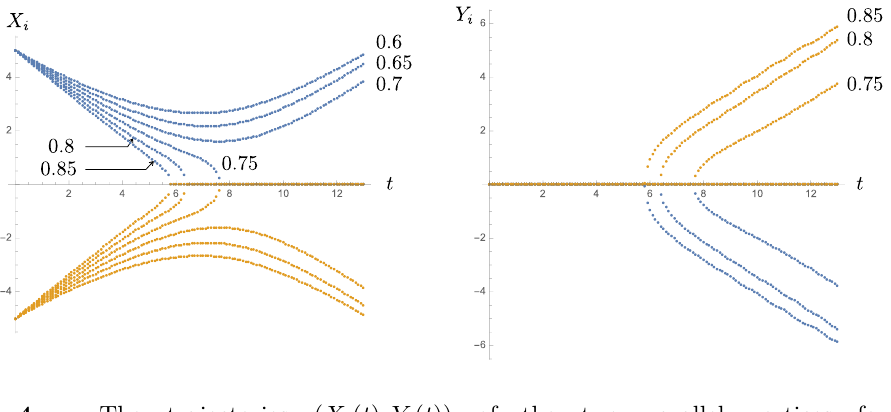
Figure 4 . The trajectories ( X i ( t ) , Y i ( t )) of the two parallel vortices for u = 0 . 6 , 0 . 65 , 0 . 7 , 0 . 75 , 0 . 8 , 0 . 85 . Parallel vortices ( α